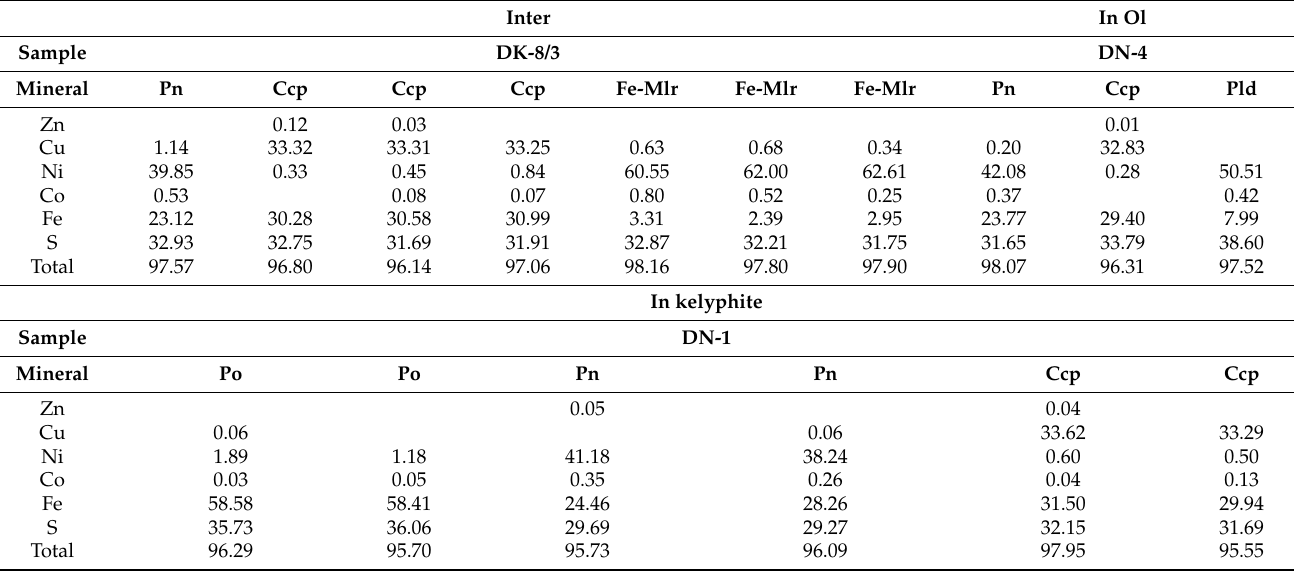
Table 3. Representative SEM analyses of sulfides in Spl-Grt lherzolites from East Antarctica (wt%).